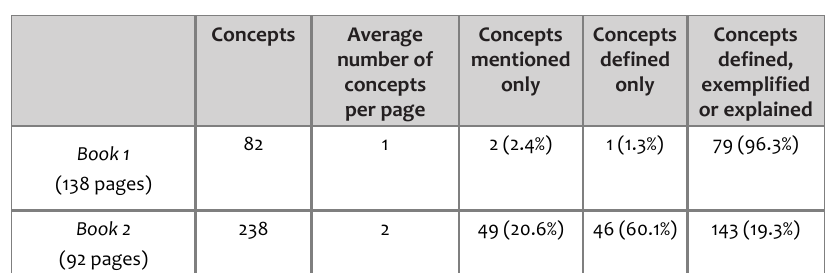
Table 2: Findings from the conceptual density